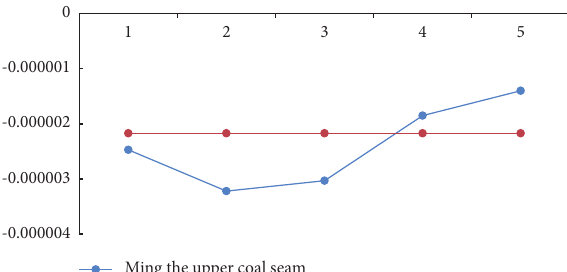
Figure 13: Comparison of vertical stress before and after excavation of upper coal seam.